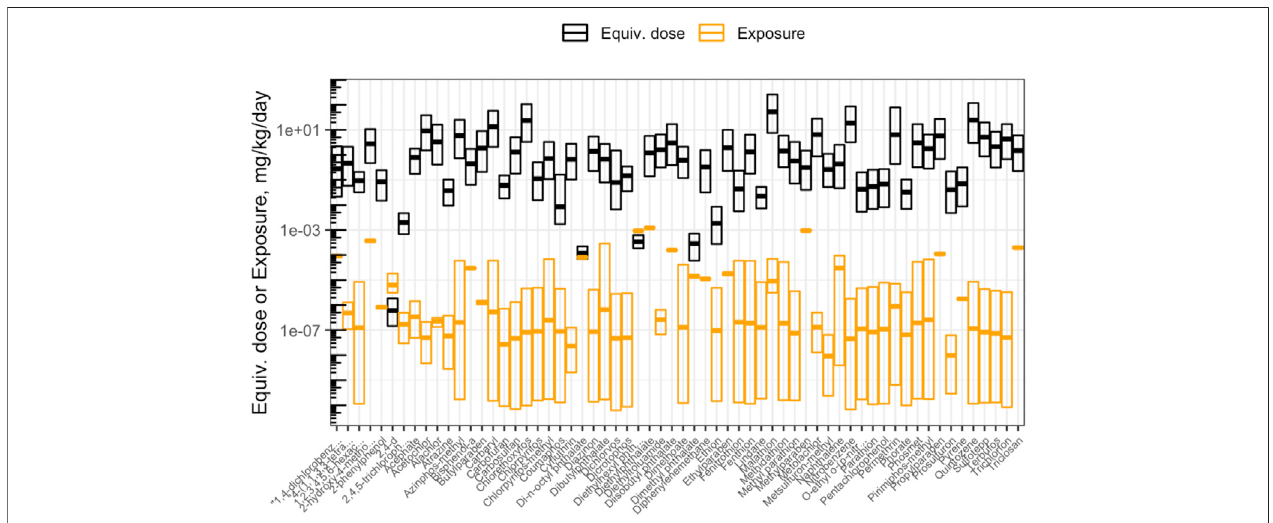
FIGURE 7 | Chemicals that were analyzed using high-throughput toxicokinetic (httk) modeling in this training module. Shown here is an example visualization producedinthismoduleillustratinghowdosesestimatedtocausetoxicity( “ Equiv.dose ” ),thatwereproducedthroughhttk,compareagainstdosesestimatedashuman exposures ( “ Exposure ” ). Chemicals are ranked according to bioactivity exposure ratios (BERs), indicating high potential risk (left) to low potential risk (right) to human health.